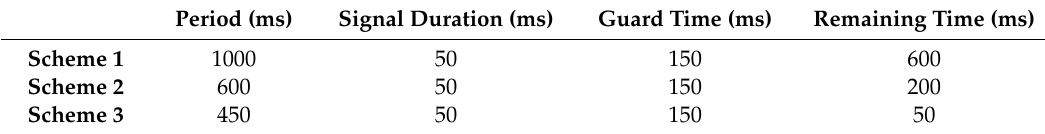
Table 1. Specific parameter values of three TDMA + FDMA transmission